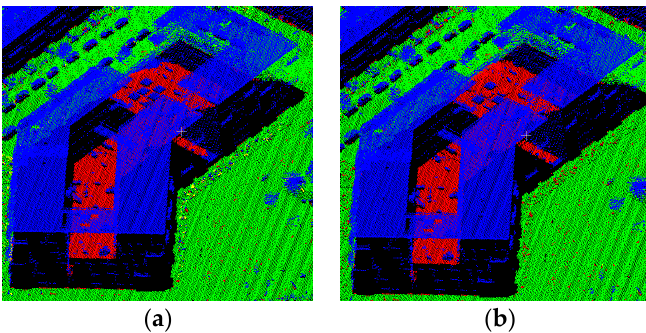
Figure 12. Error result on a large building with a lower roof in the middle: ( a ) FCN; ( b ) LAStools. Red points are those incorrectly labeled as ground points.